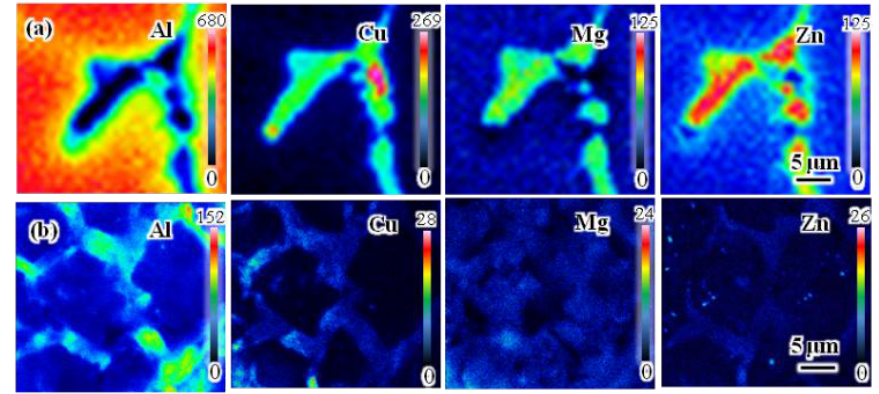
Figure 4. ( a ) Original element distribution of Al-Cu-Mg-Zn alloys by EPMA; ( b ) Al-Cu-Mg-Zn alloys after PED treatment.